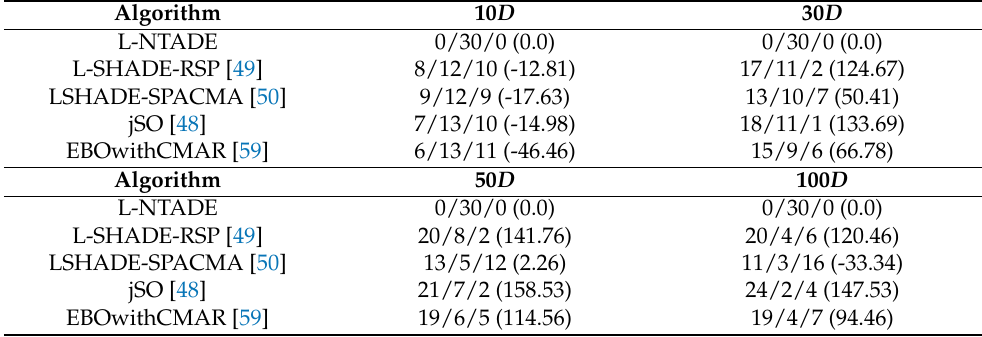
Table 5. Mann–Whitney tests of L-NTADE against other approaches, CEC 2017, number of wins/ties/losses and total standard